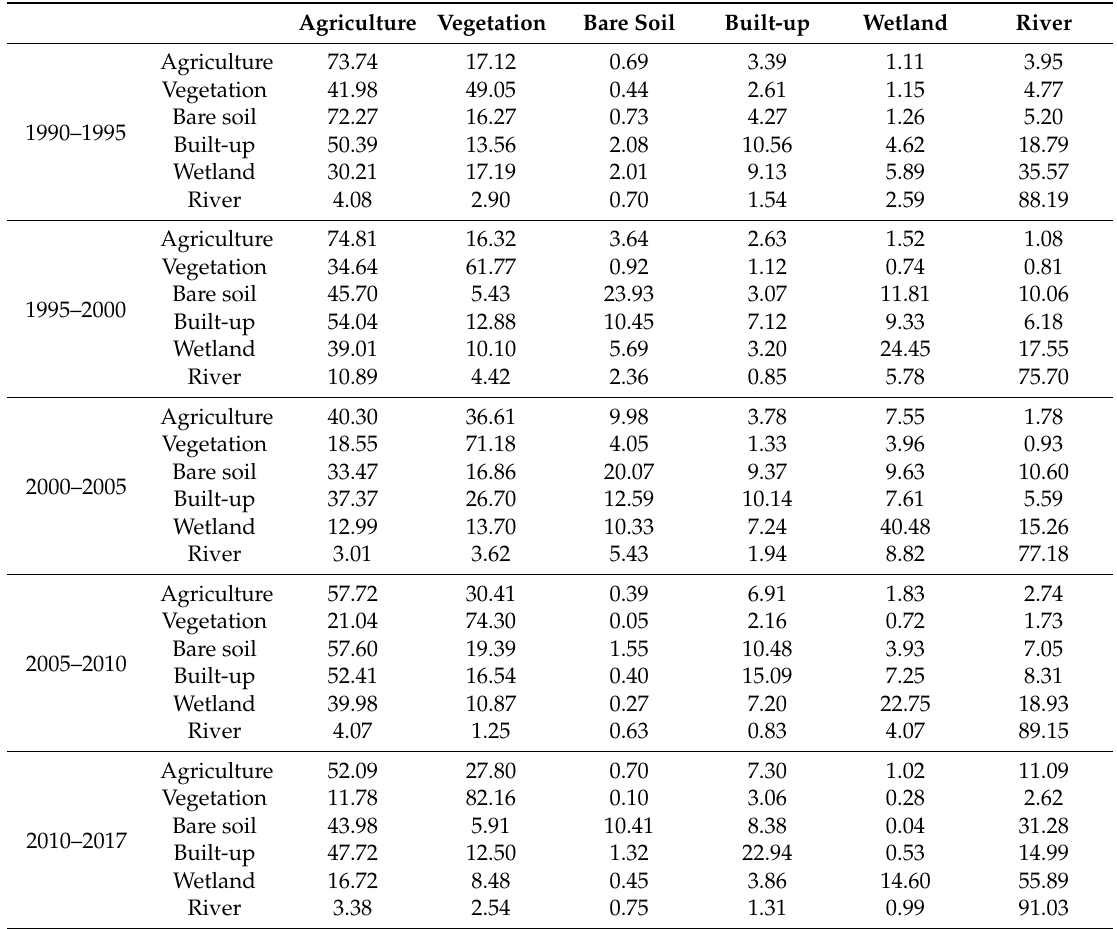
Table 8. Transition matrix showing the changes in percentage areas of the studied classes. Agriculture Vegetation Bare Soil Built-up Wetland